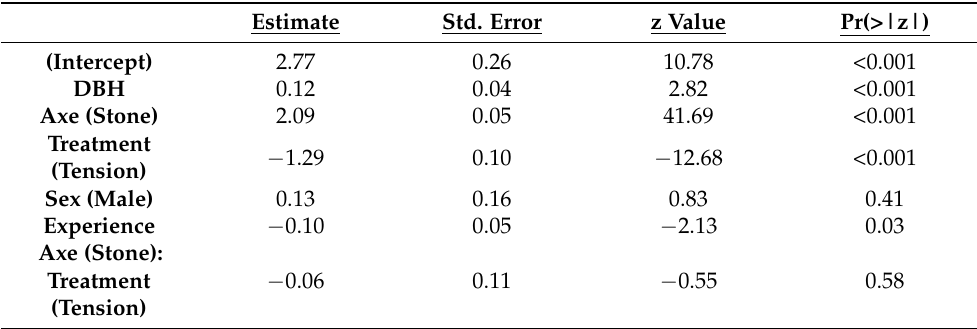
Table 1. Regression output from generalized linear mixed model estimating number of required axe